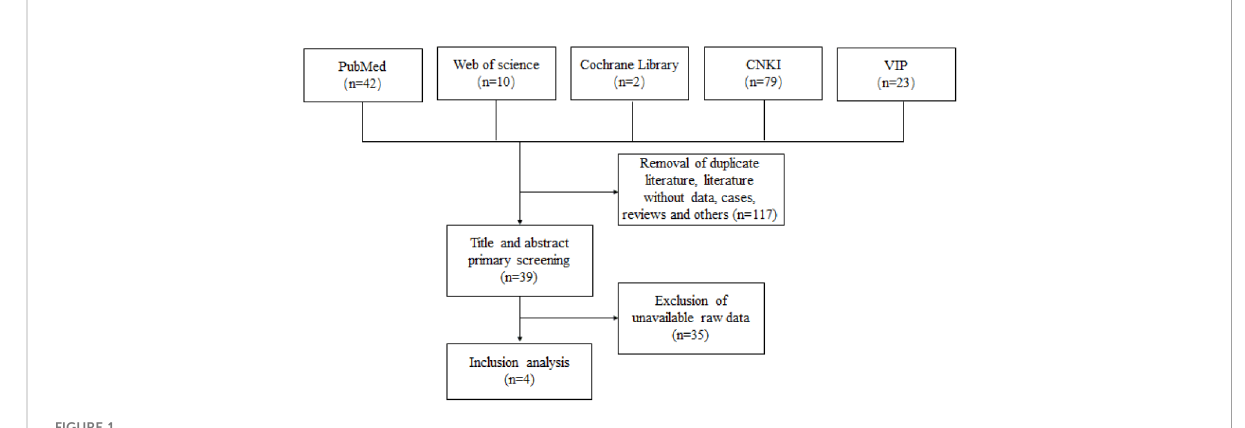
FIGURE 1 Flow chart for literature